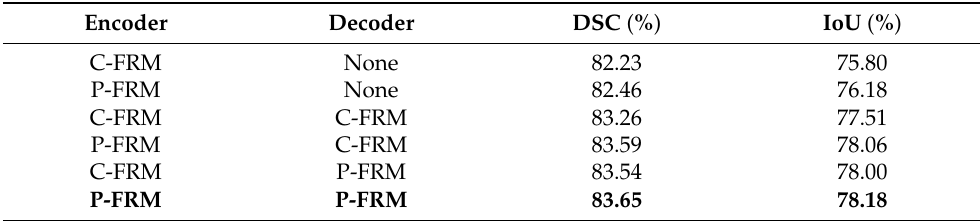
Table 3. Quantitative comparison results of different encoding and decoding blocks in terms of dice similarity coefficients (DSCs) and intersection over union (IoU).